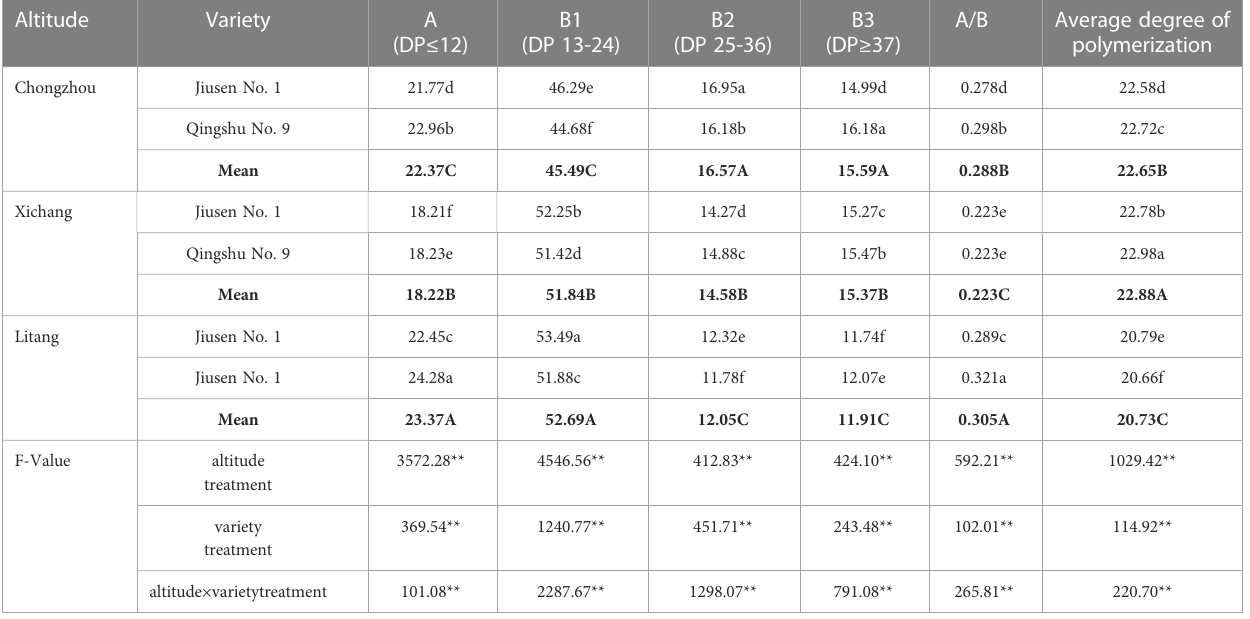
TABLE 4 Characteristics of chain length distribution, average chain length and polymerization degree of amylopectin in different treatments. Altitude